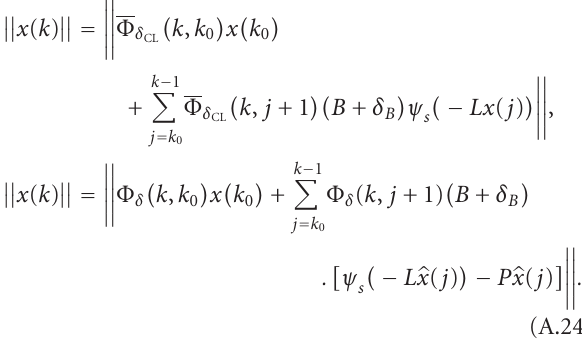
Figure 1. During availability time intervals T a